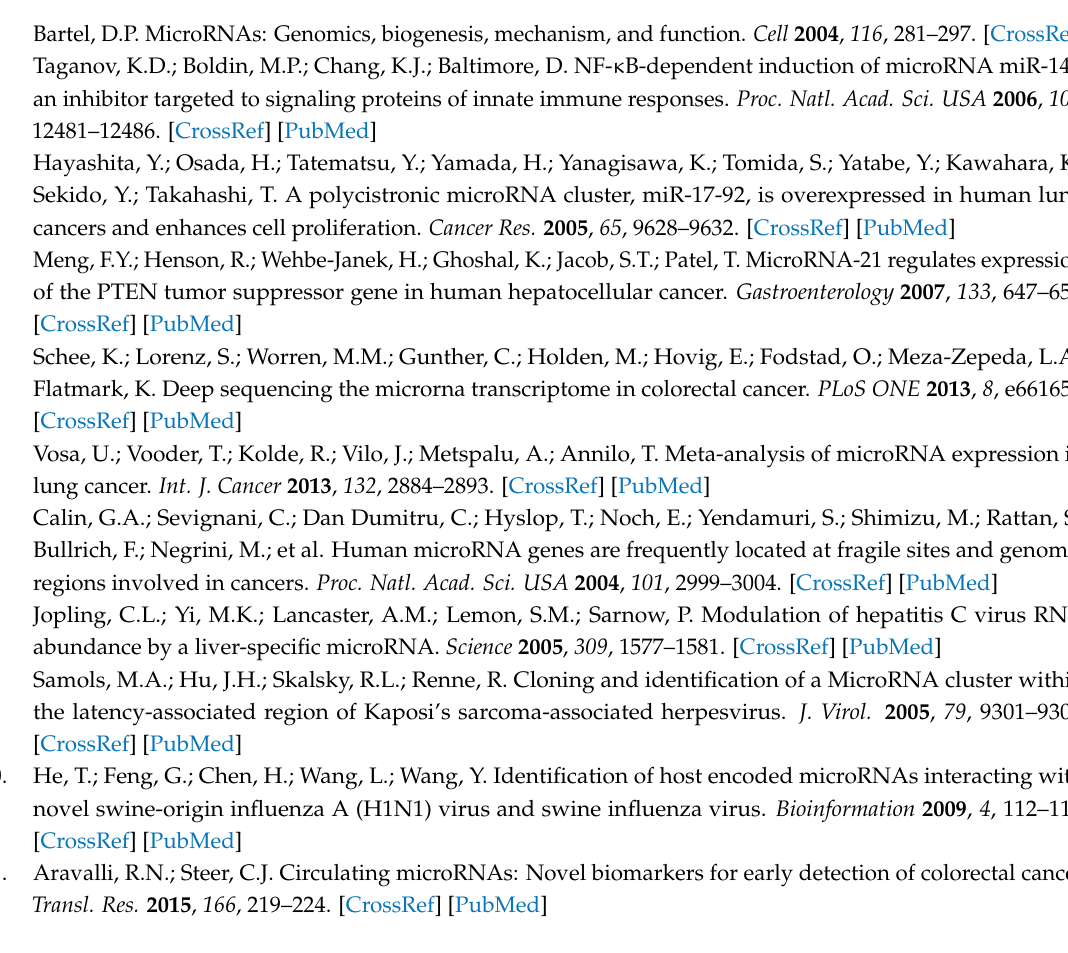
Figure S1: The body temperature (A), virus shedding (B) and viral replication in lungs (C) of dogs with CIV H3N2 infection. Figure S2: The optimal concentrations of agomir, antagomir and siRNA by assessing the expression of their target genes. The stimulation and inhibition of the cfa-miR-143 expression by agomir (A) and antagomir (B), respectively. The knockdown of the TP-53 and caspase3 by siR-TP53 and siR-caspase3, respectively